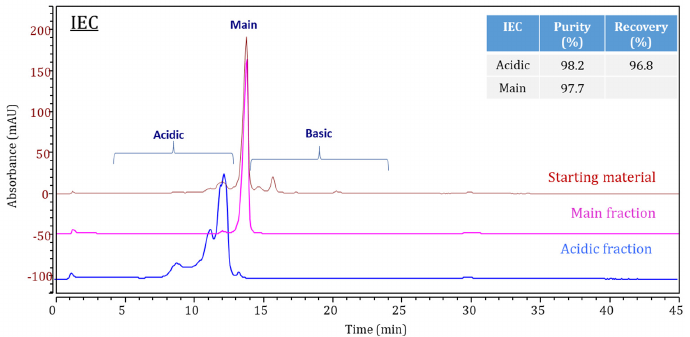
Figure 2. IEC Chromatogram overlays of mAb1 starting material ( mango ), the acidic fraction ( blue ), and the main fraction ( pink ). An inserted table listed the purity and recovery for the acidic and the main fractions.